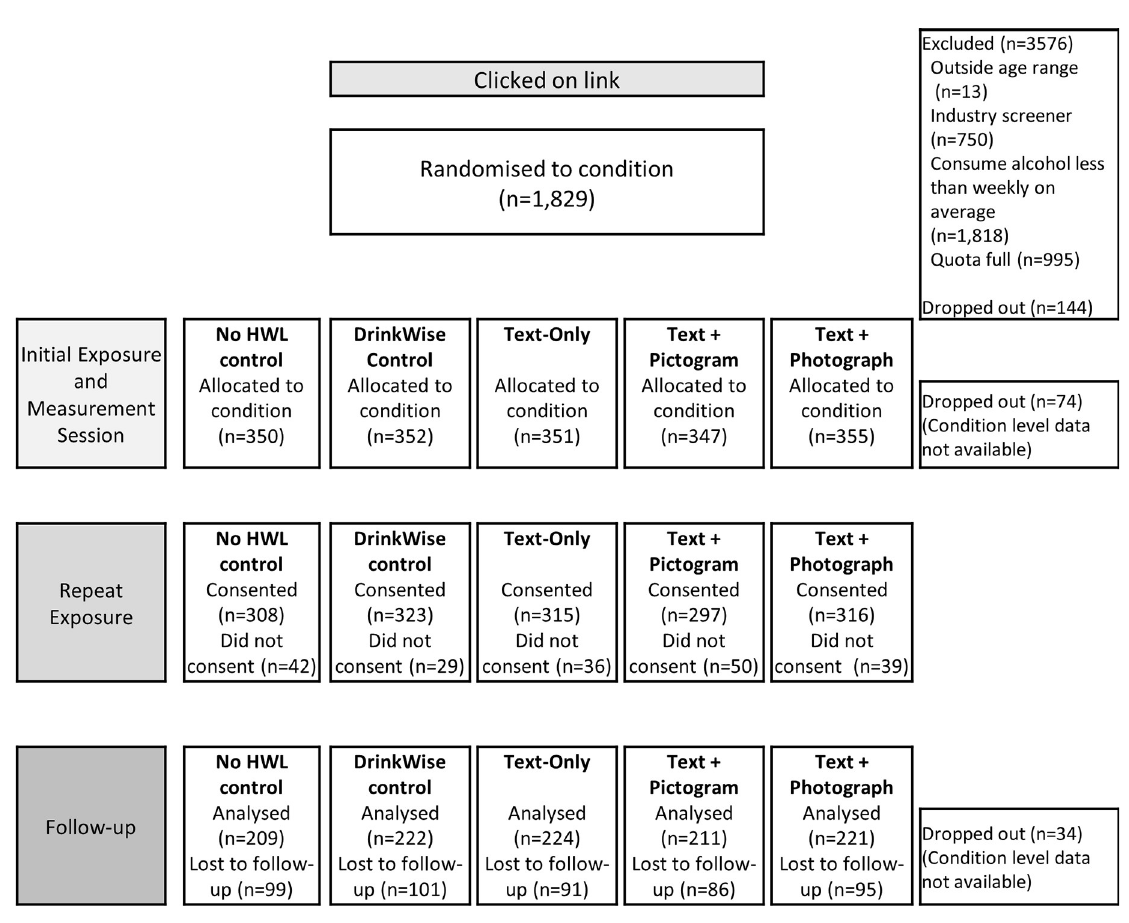
Fig 1. Condition allocation and flow of participants through